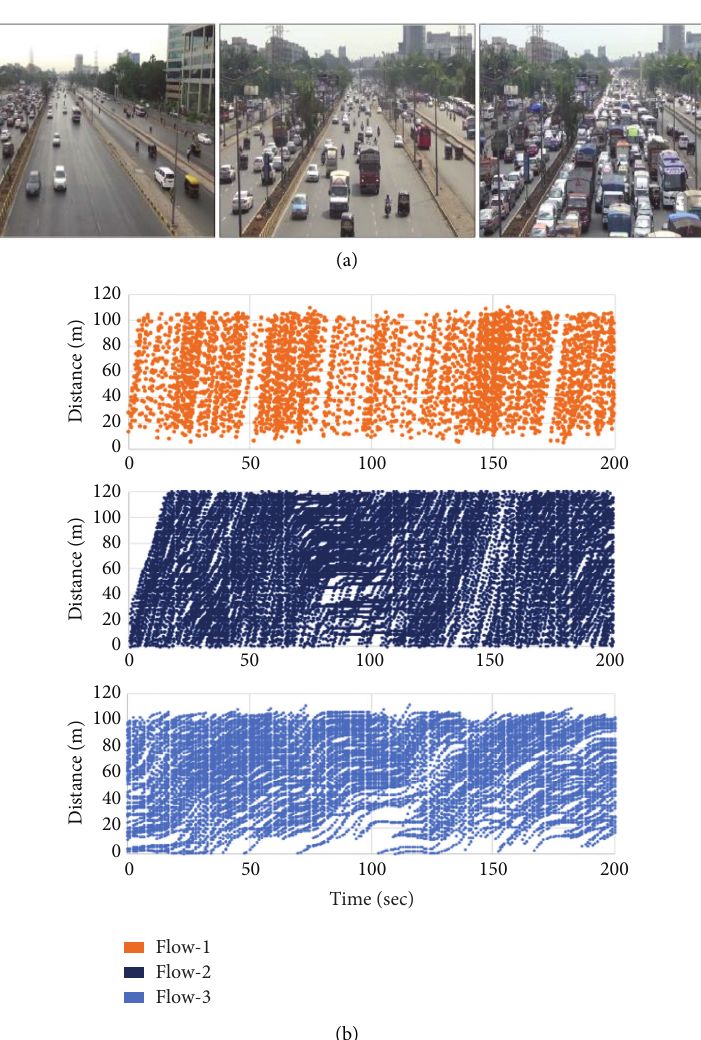
Figure 1: (a) Snapshots of the study section and (b) time-space plots of